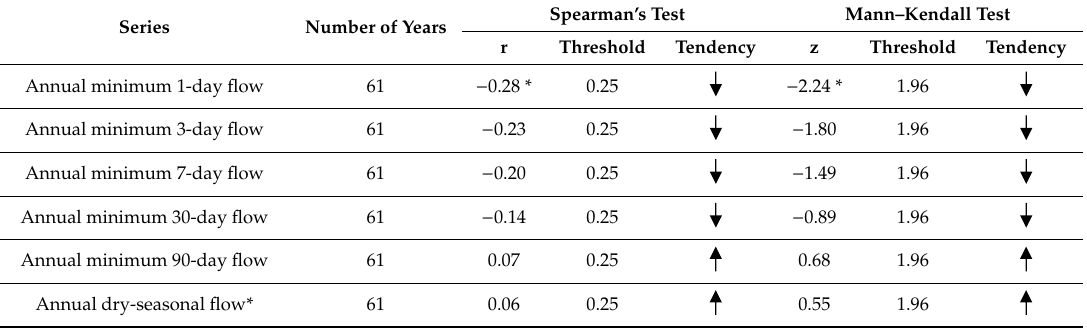
Table 3. Trends for different flow components in the LRB using the Spearman’s and Mann–Kendall tests.